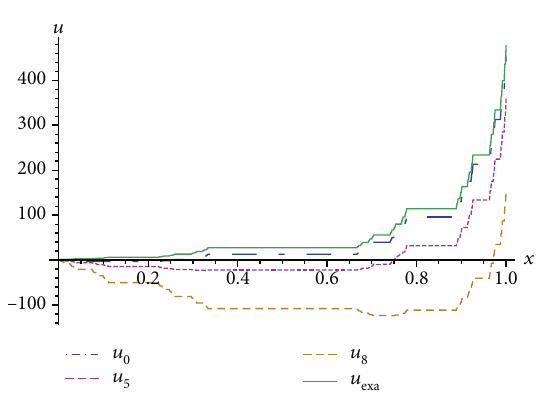
Figure 2: Divergent asymptotic solutions and exact solution in the case α = ln 2/ln 3 In Figure 2, the initial solution and 5th-order and 8th- order approximate solutions u 0 , u 5 , and u 8 and the exact solution u exa are shown by constraining them to a Cantor set with dimension α = ln 2/ln 3 ≈ 0 : 631 which does not sat- isfy the convergence condition α 0 < α ≤ 1 . In this case, u exa , u 0 , u 5 , and u 8 form a sequence of divergent approximate solutions.